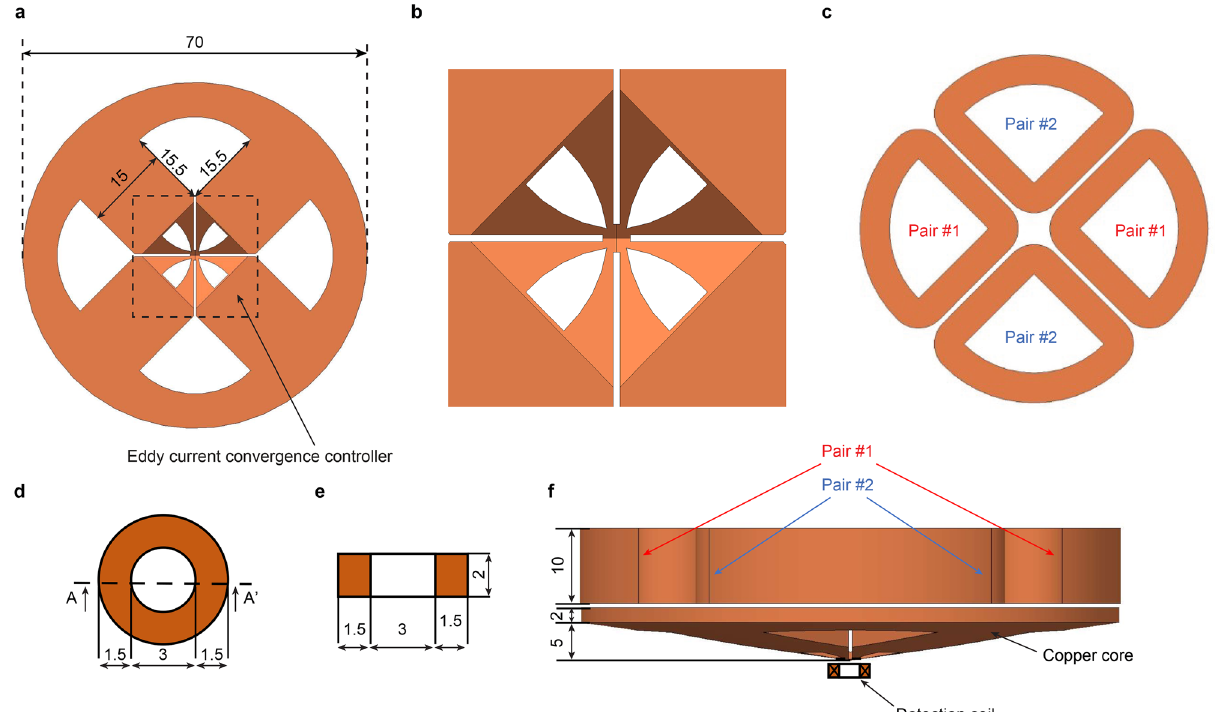
Figure 1. Structure of the RUECC probe (unit in mm). ( a ) Copper core. ( b ) EC convergence controller. ( c ) Two pairs of double excitation coils. ( d , e ) Top view and section view along A-A ′ of the detection coil. ( f ) Overall RUECC